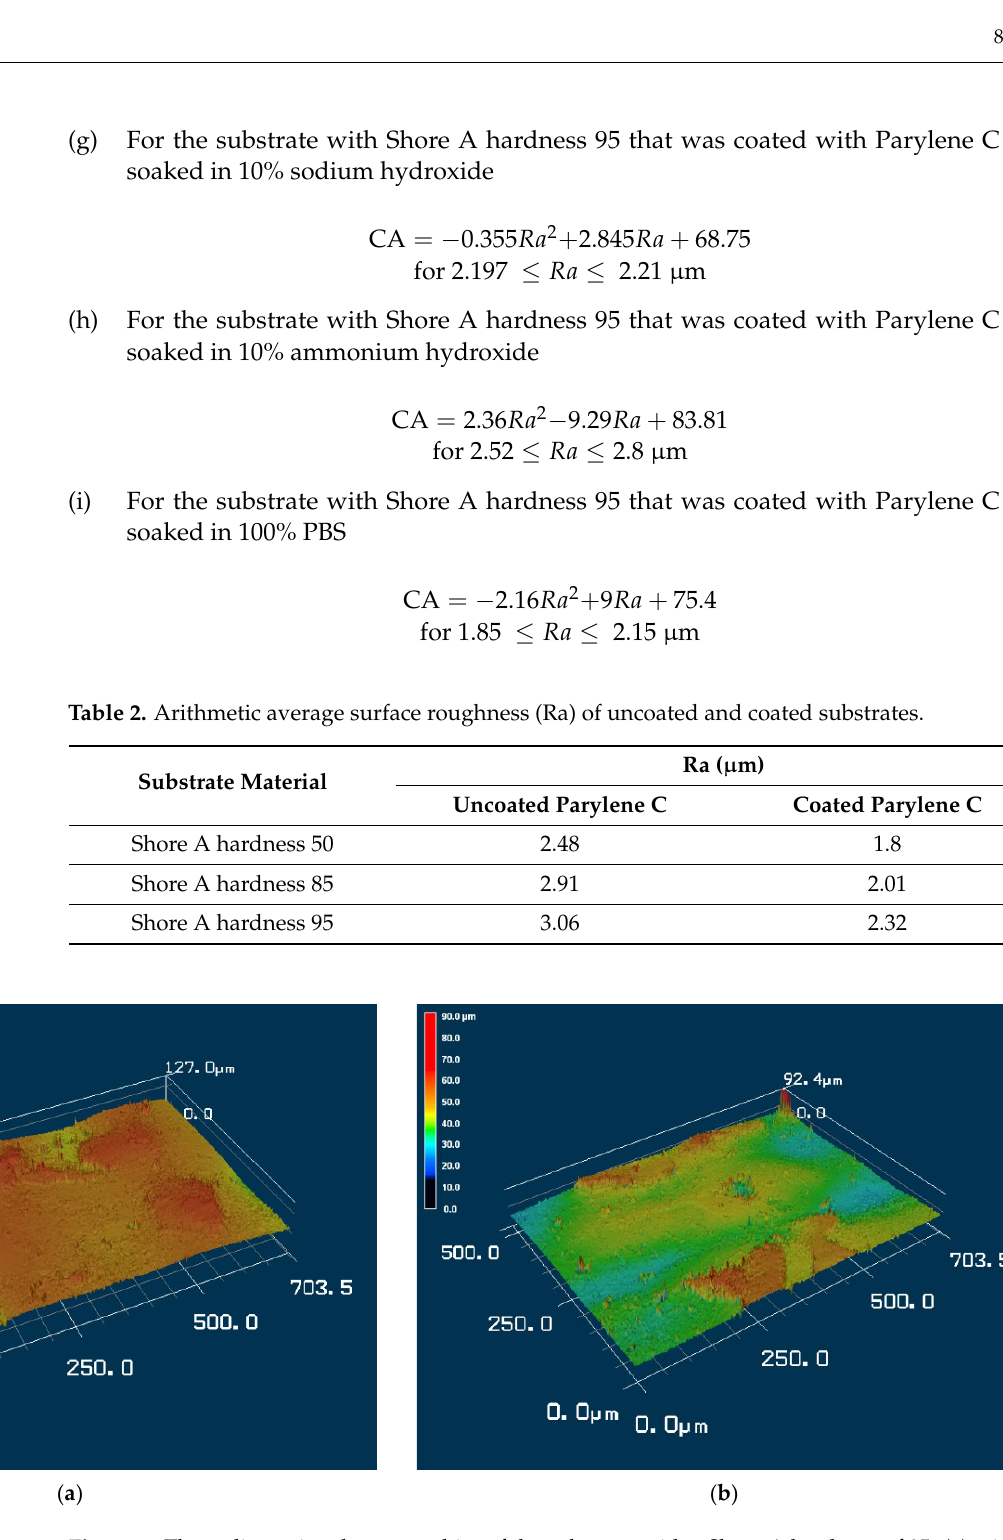
Figure 6. Three-dimensional topographies of the substrate with a Shore A hardness of 95: ( a ) without and ( b ) with Parylene C coating.